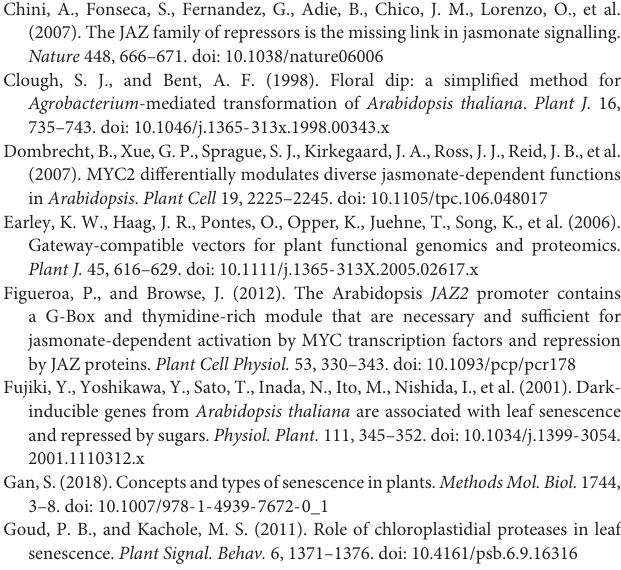
Supplementary Figure 1 | Genotyping of the usr1 mutant. (A) The Gene structure of AtUSR1 and the usr1 ( Salk_095353 ) T-DNA insertion in the 5 (cid:48) UTR region. (B) Transcript levels of AtUSR1 in Col-0, usr1 mutant, and complementation plants harboring proAtUSR1::USR1/usr1 . Supplementary Figure 2 | Expression of AtUSR1 in two independent overexpression lines. Supplementary Figure 3 | Phenotype of attached leaves under dark conditions. (A) Fully expanded leaves were wrapped with aluminum foil for 6 days. (B) Chlorophyll contents of different genotypes as indicated. (C) Membrane leakage rates of different genotypes as indicated. Supplementary Table 1 | Primers used in this